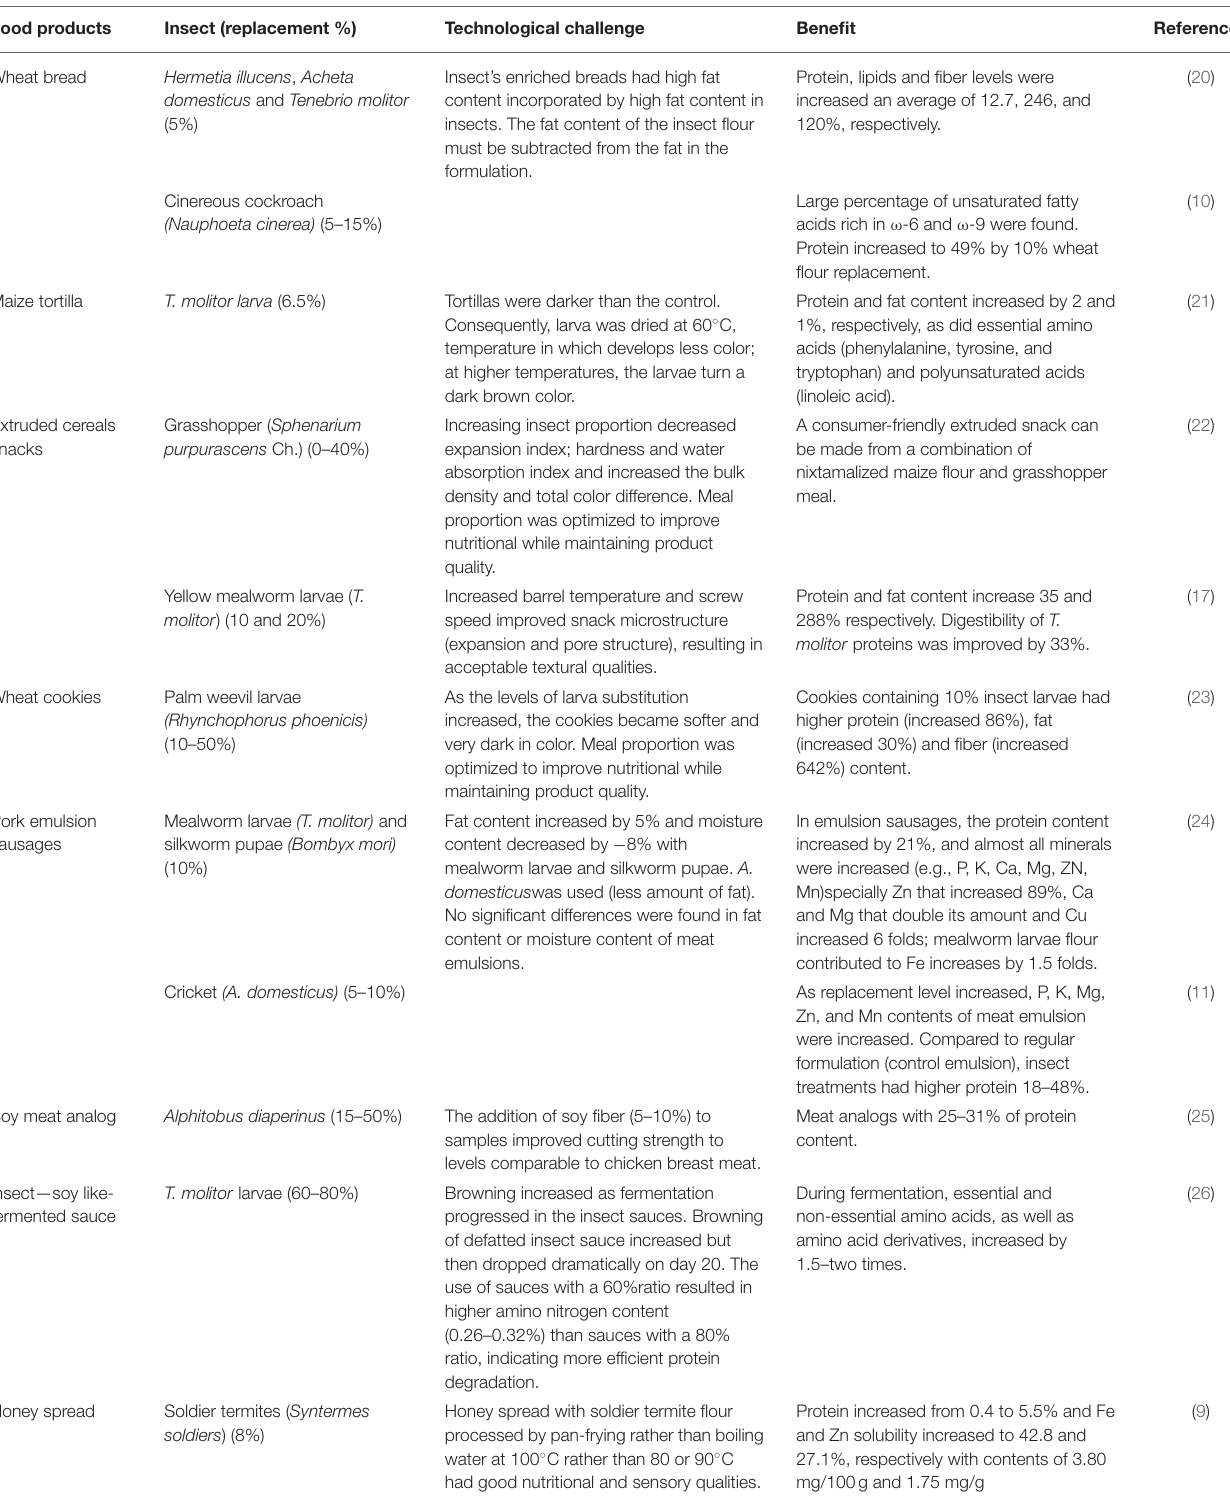
TABLE 1 | Benefits and challenges in the incorporation of insects in food